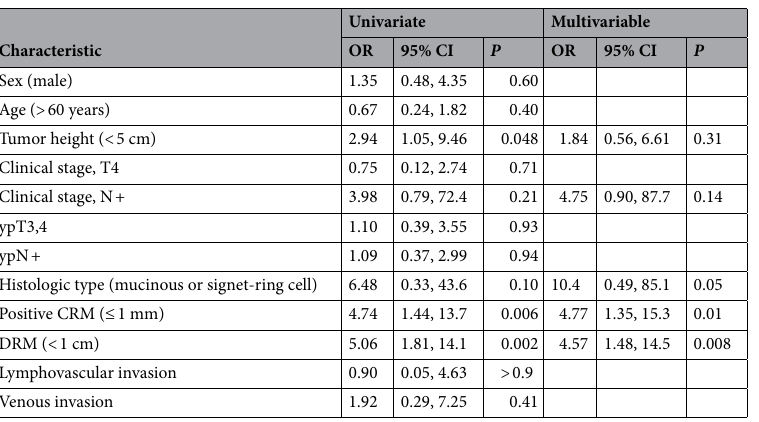
Table 3. Univariate and multivariable analyses of risk factors for local recurrence in patients with locally advanced rectal cancer who underwent preoperative chemoradiotherapy followed by rectal excision. CRM circumferential resection margin, DRM distal resection